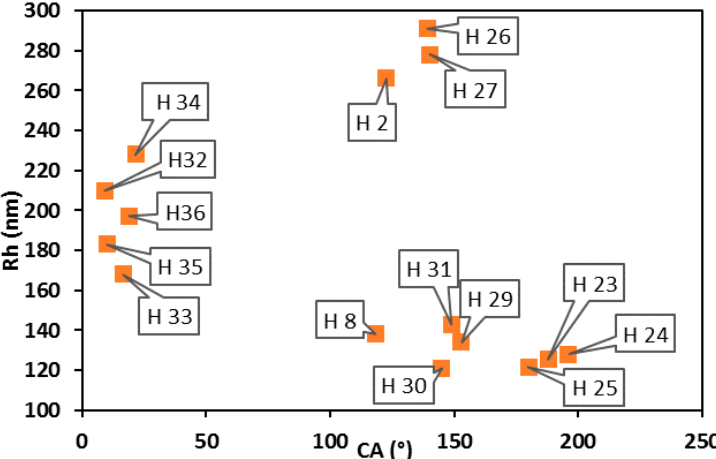
Figure 7. Static contact angles of HFBMA NP thin films correlated with R h values of NPs.